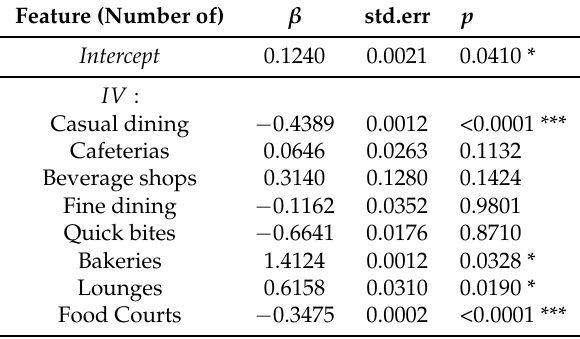
Table 2. Regression results for the relationship between the built environment ( IV ) and user’s dining posting behavior on Instagram ( DV ): IV → DV with DV being the total number of dining posts made by an individual. Feature (Number of) β std.err p Intercept